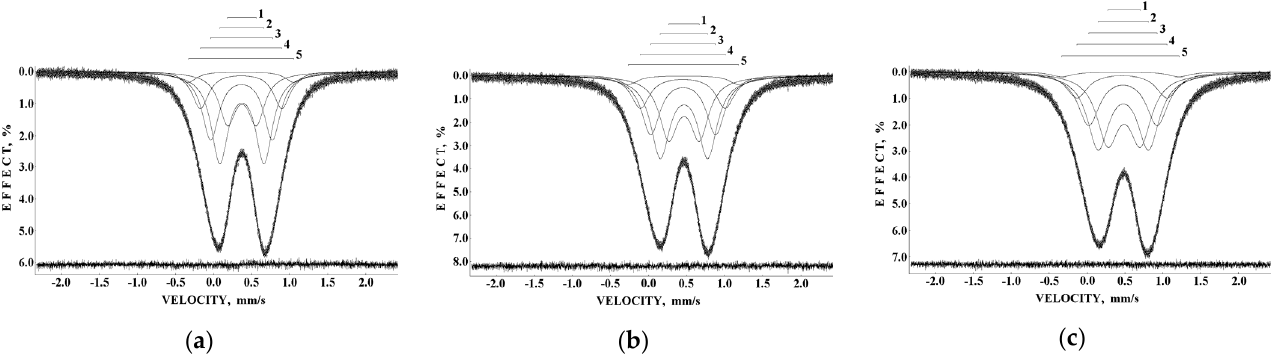
Figure 6. Mössbauer spectra of human liver ferritin (100 mg) measured in 4096 channels at 295 K ( a ), 140 K ( b ) and 90 K ( c ). The indicated five components (1–5) are the results of the best fits within the new heterogeneous model for the iron core with equal line width for five components. The differential spectra are shown on the bottom. Adapted from Ref. [49] with permission from Elsevier: Spectrochimica Acta, Part A: Molecular and Biomolecular Spectroscopy, Vol. 172, Oshtrakh